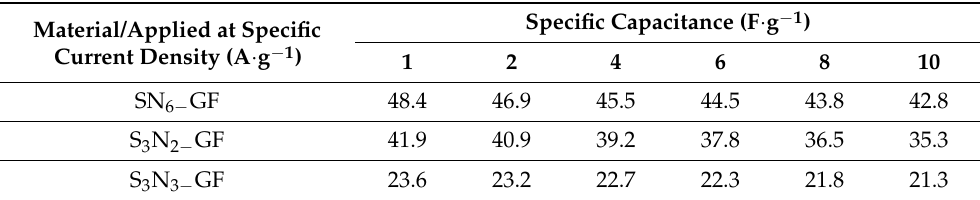
Table 4. Summary of specific capacitance values obtained for the different co-doped materials